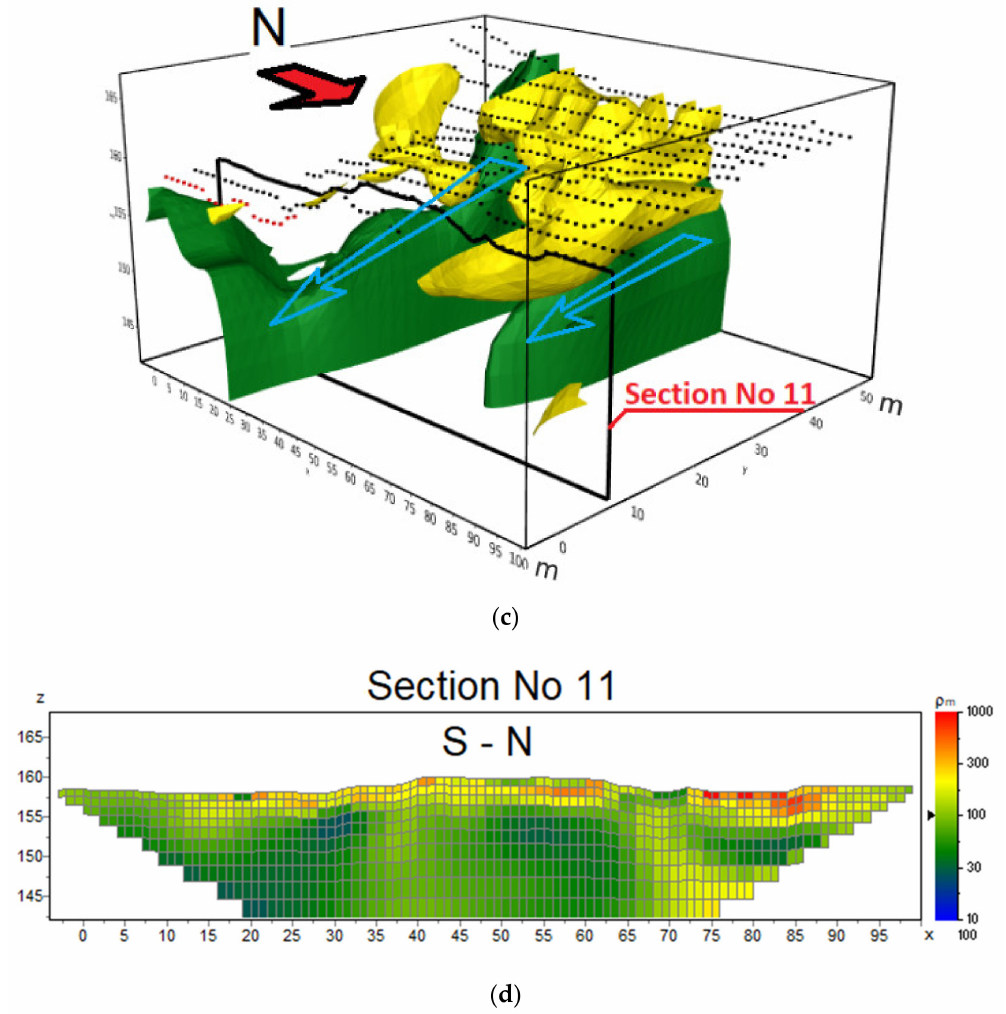
Figure 7. Three-dimensional (3D) high and low resistivity zones in the subsurface created through the inversion of 13 ERT profiles. The 3D model in view from ( a ) SE and ( c ) NE (the black dots represent the location of each electrode) and two characteristic sections ( b ) No 3 and ( d ) No 11 of the 3D